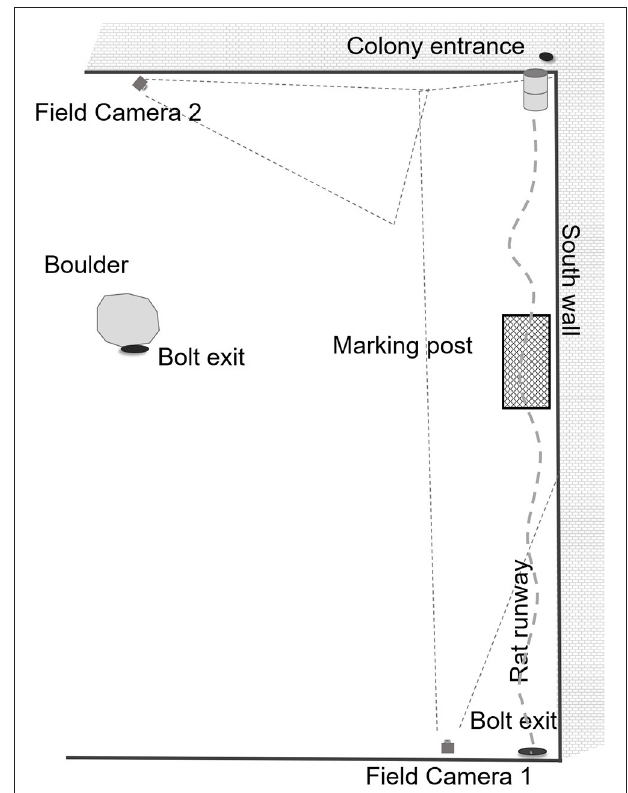
FIGURE 1 | Experimental set-up for feral cat trials at a semi-enclosed industrial building in New York City from Dec. 27, 2017—May 28,